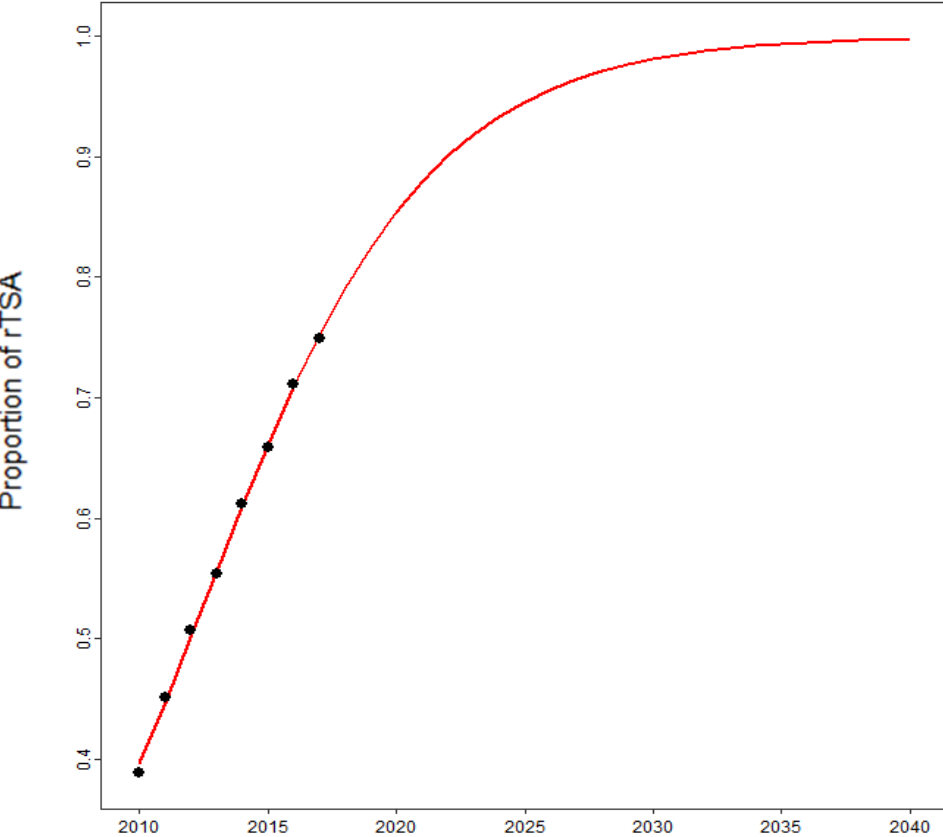
Figure 4. Reported and predicted case numbers per age group from 2010 to 2040.